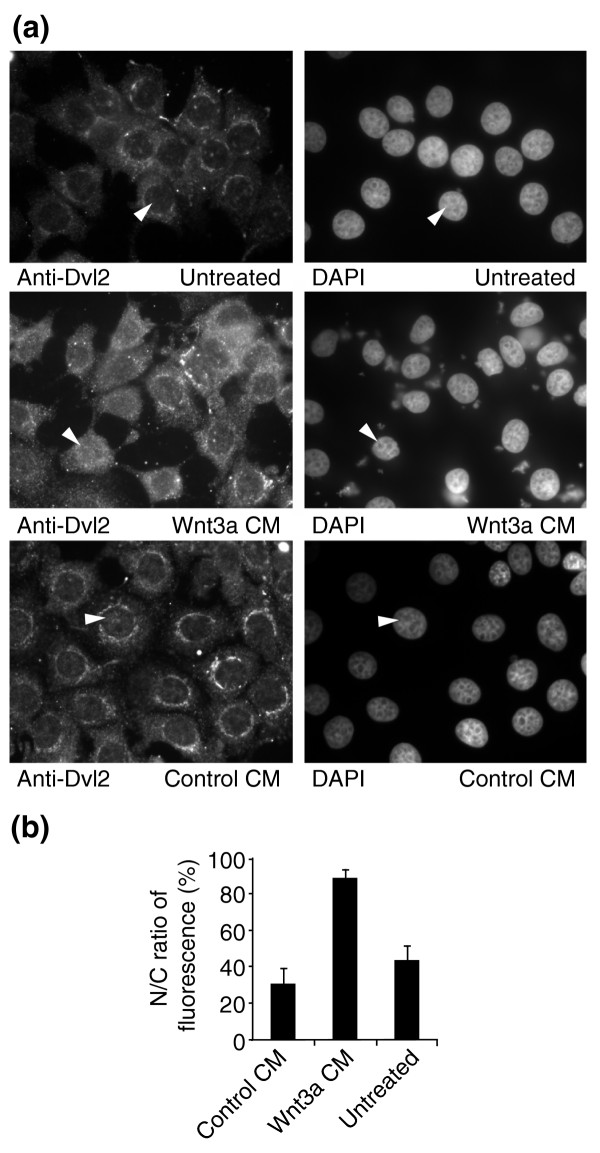
Nuclear translocation of Dvl2 upon Wnt3a treatment. (a) MCF7 cells were treated either with Wnt3a-conditioned or control medium for 6 h, fixed and immunostained with anti-Dvl2 antibodies. In control cells, cytoplasmic and perinuclear staining is visible. Wnt3a-conditioned, but not control, medium enhanced nuclear translocation of Dvl2. DAPI staining indicates the position of cell nuclei. Corresponding cells are shown by arrowheads. (b) Nuclear/cytoplasmic (N/C) ratios of fluorescence were calculated for each panel in (a) as the mean +/- standard deviation.